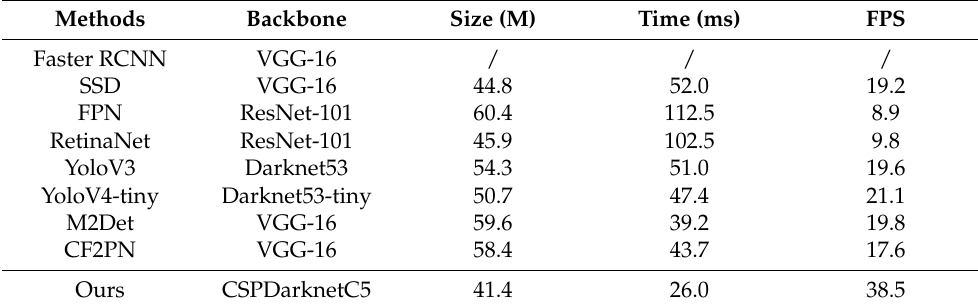
Table 5. Model size and inference speed of different methods for DIOR dataset on